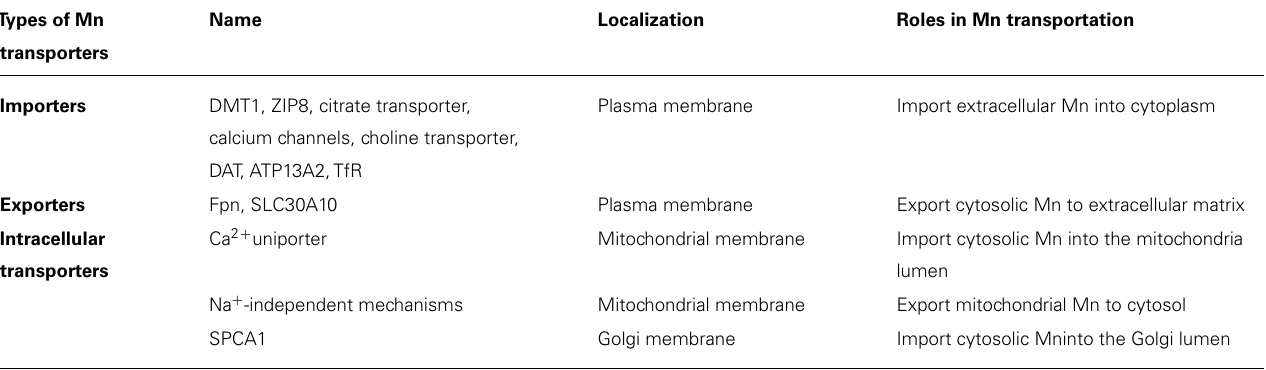
Table 1 | Different types of Mn transporters in a